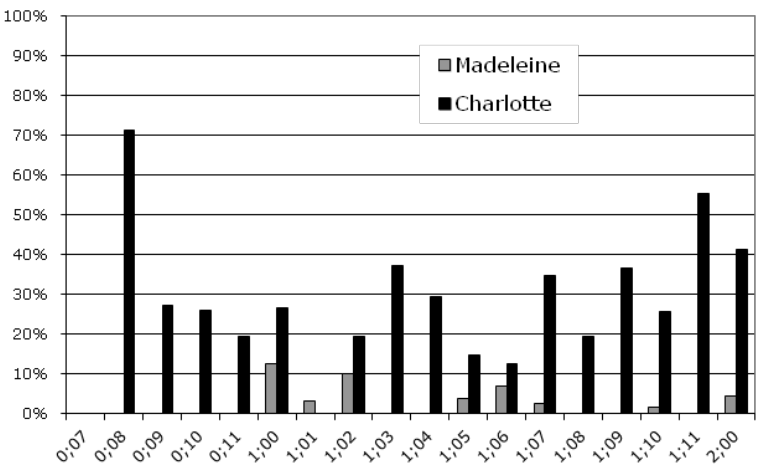
Figure 3. Percentage of pointing gestures towards persons out of all pointing gestures produced according to age in Madeleine and Charlotte’s data